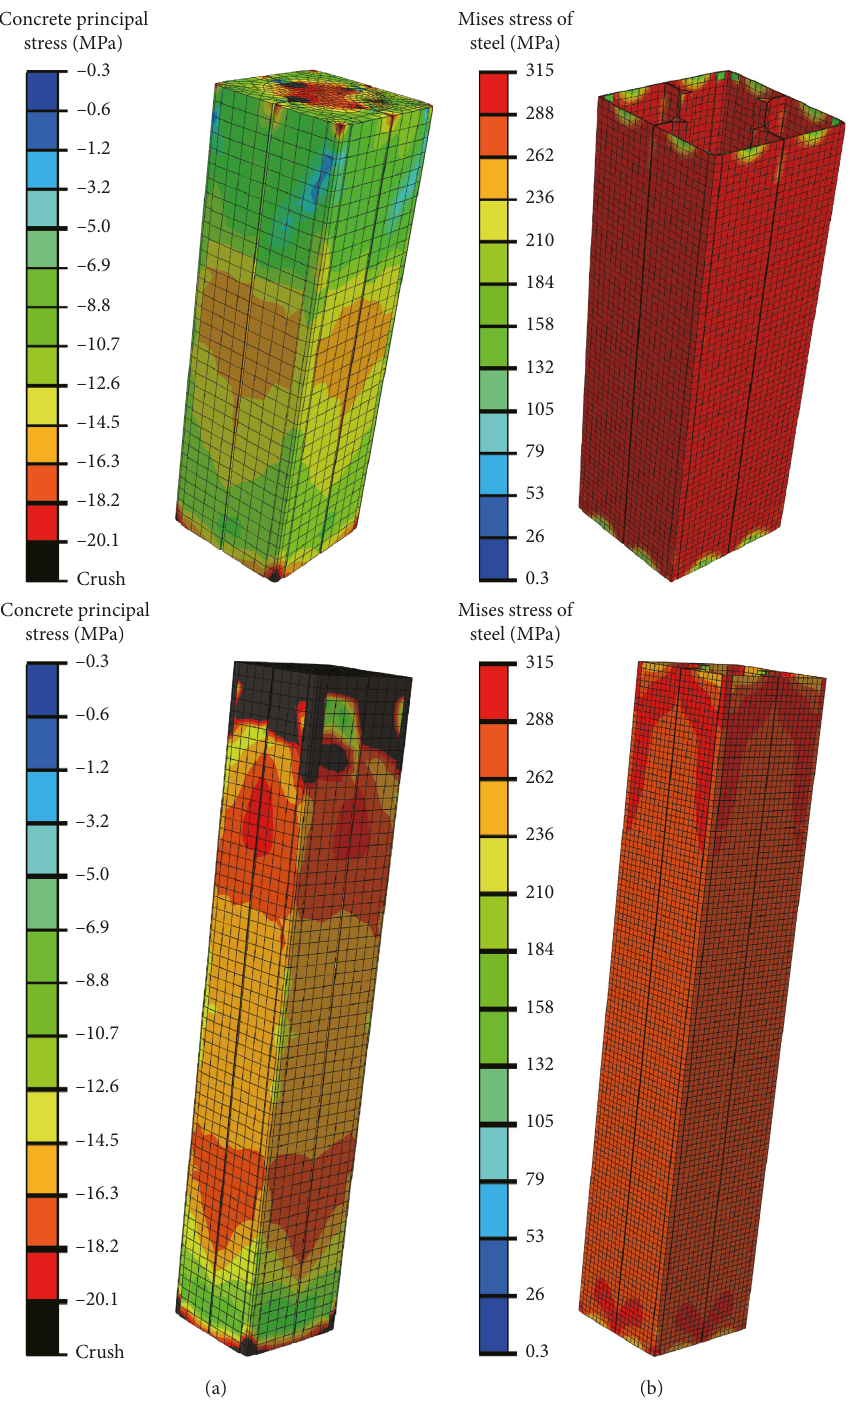
Figure 21: Concrete stress and steel stress of (a) B650 and (b)